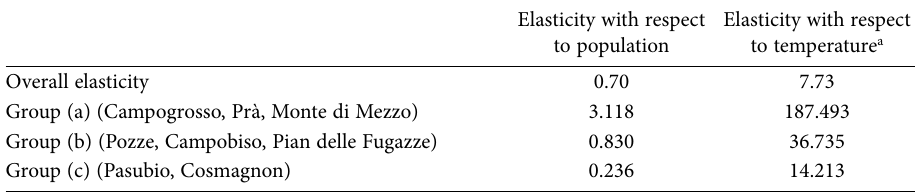
Table 3. Estimated rental price